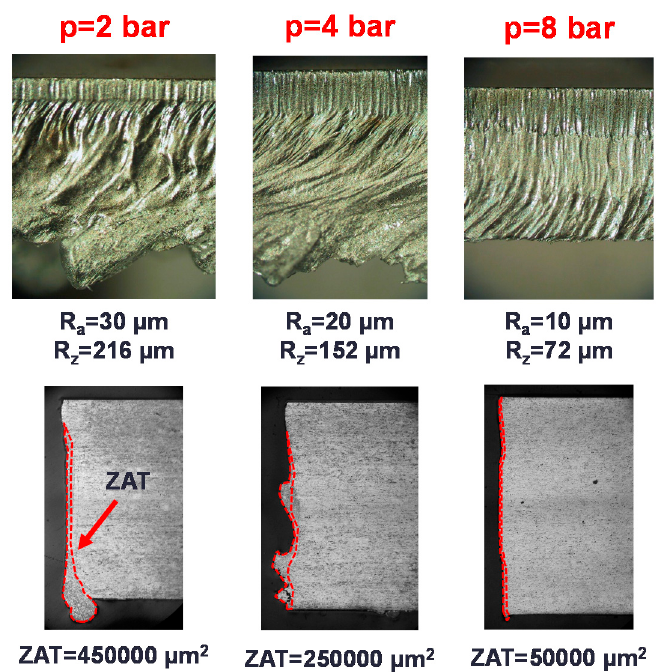
Figure 2. Cutting edge and cross section of aluminum-cooper alloy samples (2024-T3) processed by means of a CO 2 laser using a conventional cutting head working with three different supplying pressures (Processing parameters: Laser power P = 2500 W, cutting speed v c = 4000 mm/min, focal length f = 127 mm, stand-off Z = 1.5 mm, conical nozzle, nozzle diameter d = 2 mm, assist gas: argon).